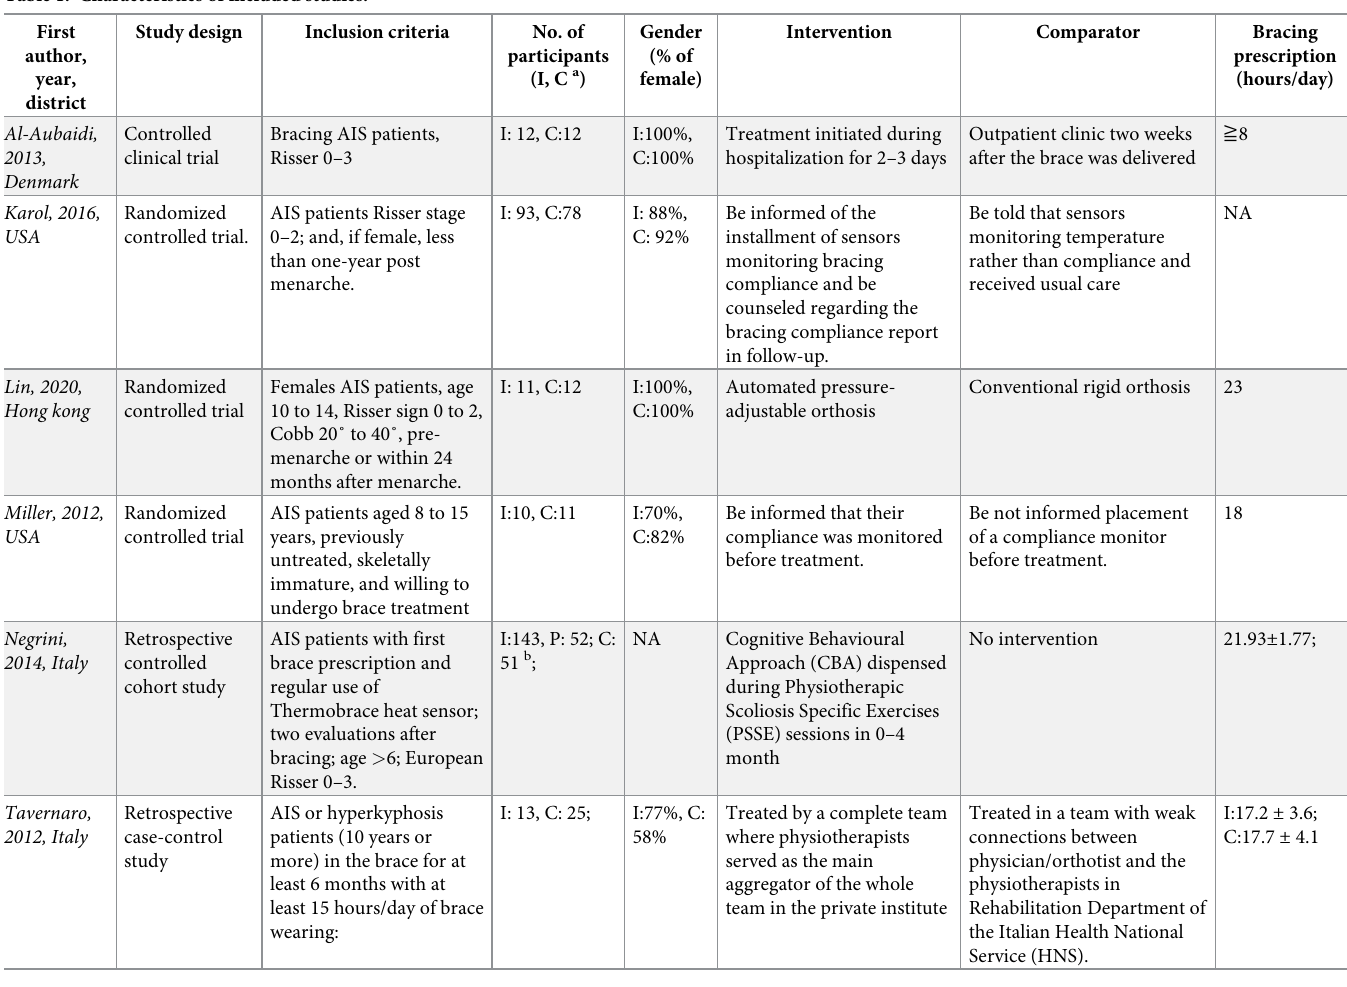
Table 1. Characteristics of included